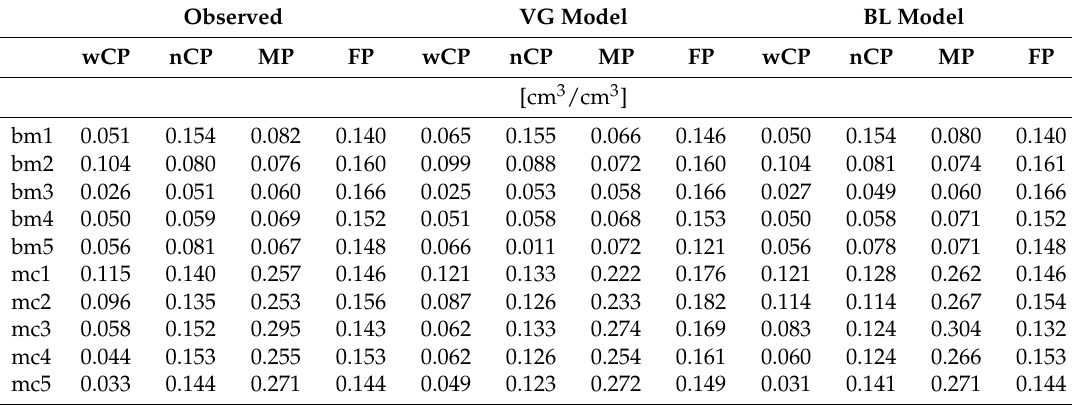
Table 8. Bimodal and observed pore size distribution of the boulder marl (bm) and the marsh clay (mc) considering the unimodal VG model [9] and the bimodal BL model [10]. The pores sizes are classified